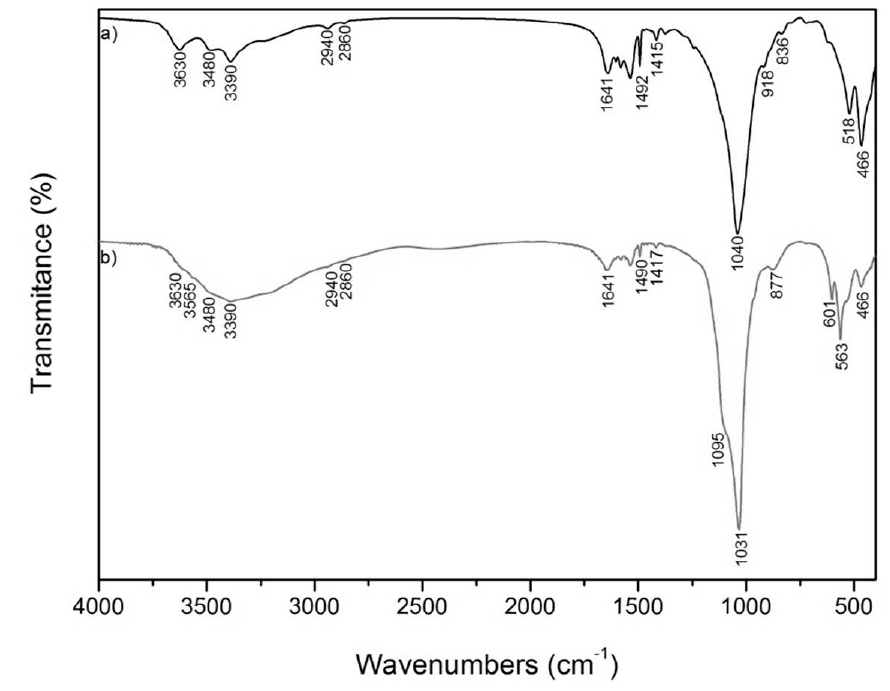
Figure 3. FTIR spectra of: ( a ) MCA and ( b ) MCAH.